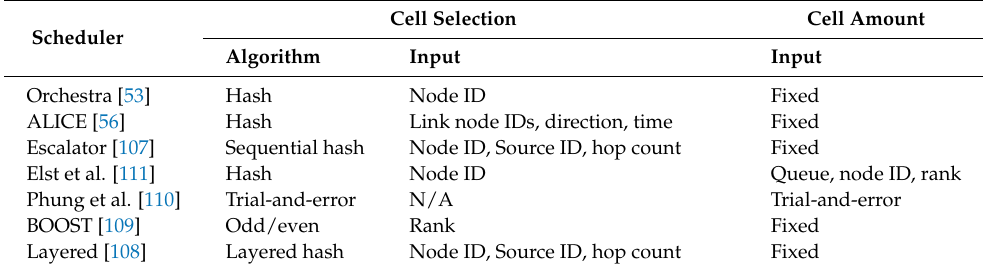
Table 5. Components of autonomous TSCH schedulers.